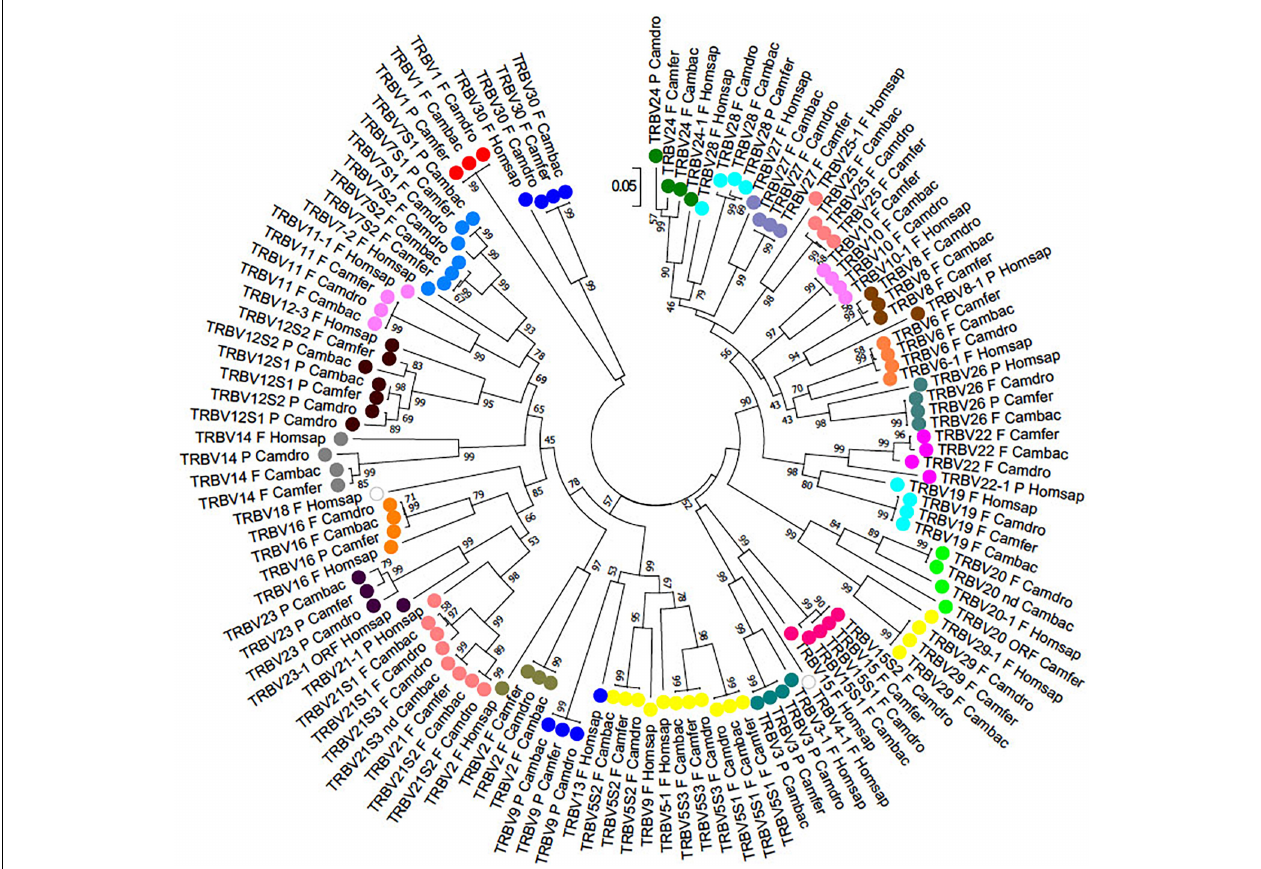
FIGURE 2 | The NJ tree inferred from the wild and domestic Bactrian camel, human and dromedary TRBV gene sequences. The evolutionary analysis was conducted in MEGA7 (Kumar et al., 2016). The optimal tree with the sum of branch length = 8.80179972 is shown. The percentage of replicate trees in which the associated taxa clustered together in the bootstrap test (100 replicates) is shown next to the branches (Felsenstein, 1985). The tree is drawn to scale with branch lengths in the same units as those of the evolutionary distances used to infer phylogenetic trees. The evolutionary distances were computed using the p-distance method (Nei and Kumar, 2000) and are in the units of the number of base differences per site. The analysis involved 123 nucleotide sequences. Codon positions included were 1st+2nd+3rd+Noncoding. All positions containing gaps and missing data were eliminated. There were a total of 130 positions in the final dataset. The different colors highlight the distribution of the phylogenetic groups. The gene functionality according to IMGT rules (F, functional, ORF, open reading frame, P, pseudogene) is indicated; “nd” indicates that the nucleotide sequence of the gene is incomplete and its functionality cannot be defined. The IMGT 6-letter for species (Homsap, Camdro, Camfer, Cambac) standardized abbreviation for taxon is